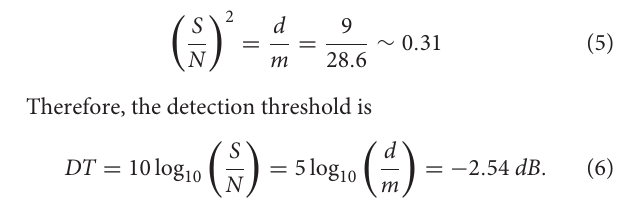
Frontiers in Marine Science |